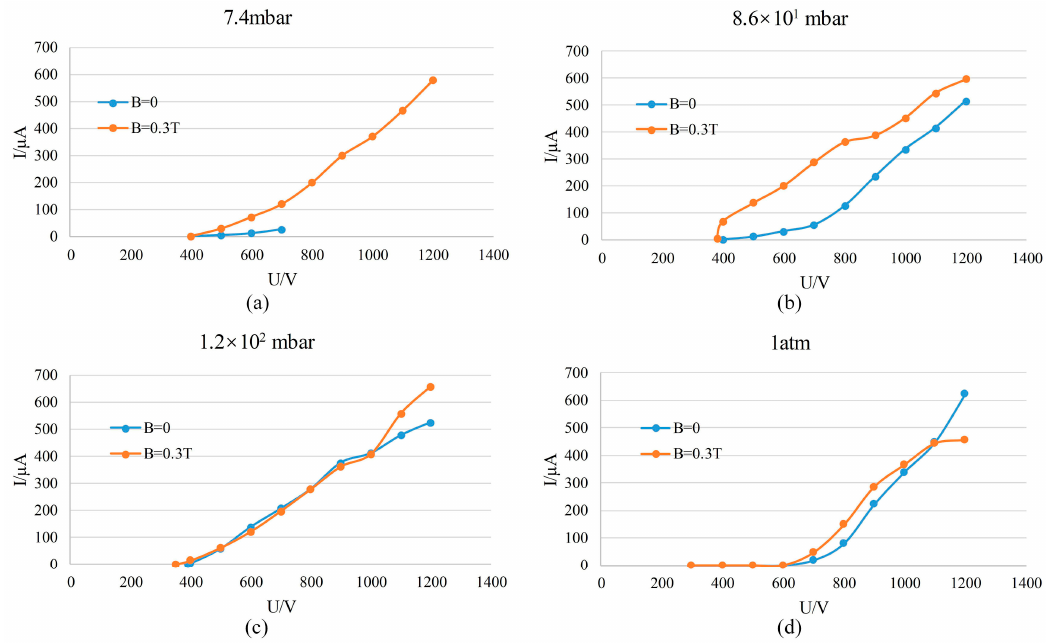
Figure 10. The discharge currents of with- and without-magnet configurations vs. voltage: ( a ) p = 7.4 mbar; ( b ) p = 8.6 × 10 1 mbar; ( c ) p = 1.2 × 10 2 mbar; ( d ) p = 1atm.